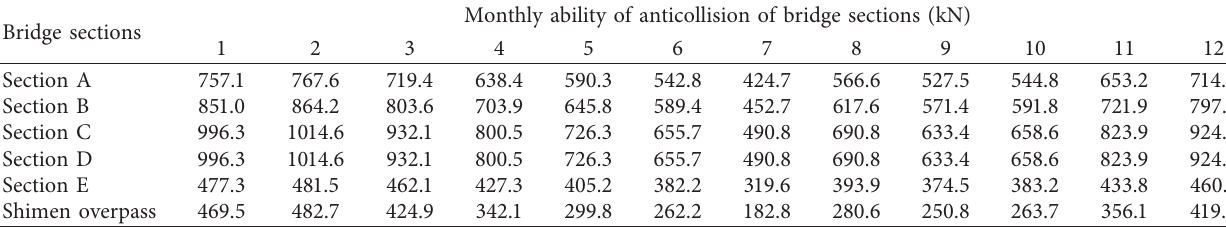
Table 6: Capacity of anticollision of the pier of bridge